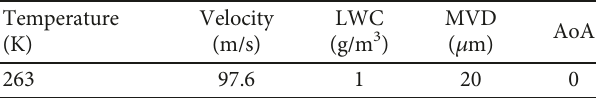
Table 3: Environment conditions of in- fl ight